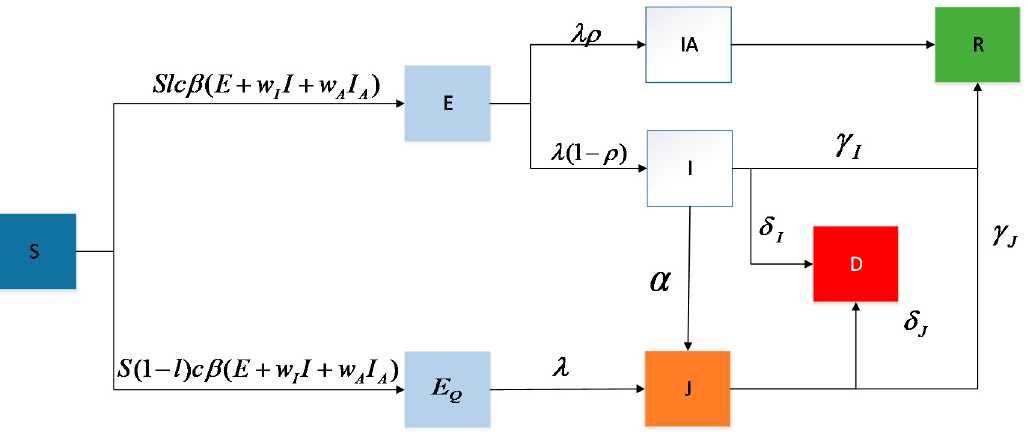
Figure 2. Process illustration. Figure 2. Process